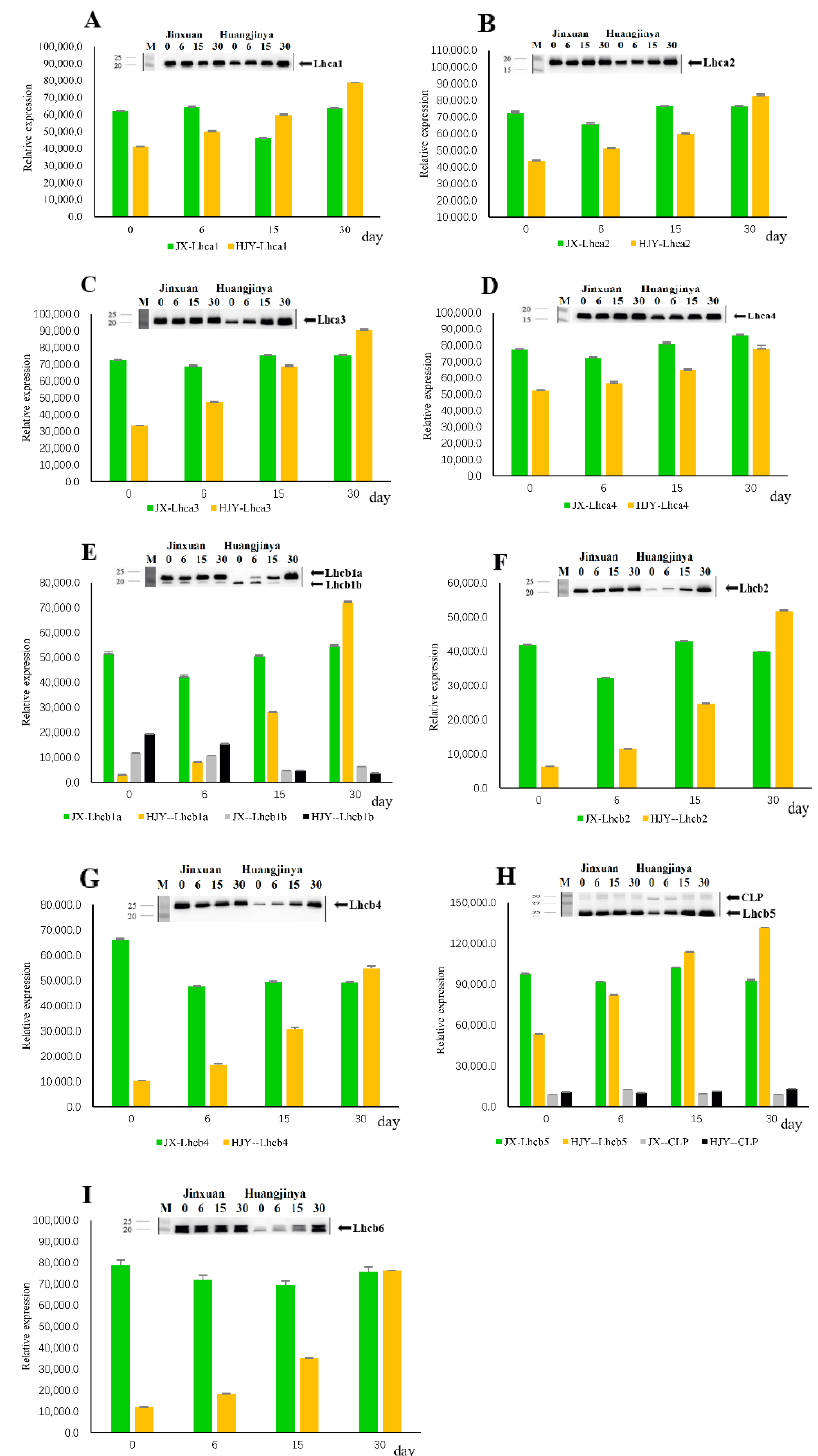
Figure 2. ( A – I ) Immunoblotting of LHC proteins during shading treatment. Thylakoids were extracted from the 4th leaf beneath apex bud on tea shoots, and 1 µ g of chlorophyll was used each lane. The blots were probed with specific antibodies: anti-Lhca1, anti-Lhca2, anti-Lhca3, anti-Lhca4, anti-Lhcb1, anti-Lhcb2, anti-Lhcb4, anti-Lhcb5, and anti-Lhcb6. CLP, crosslinking product. The data 0, 6, 15, and 30 refer to the days of shading treatment. The bars are expressed as mean ± standard deviation ( n = 3).